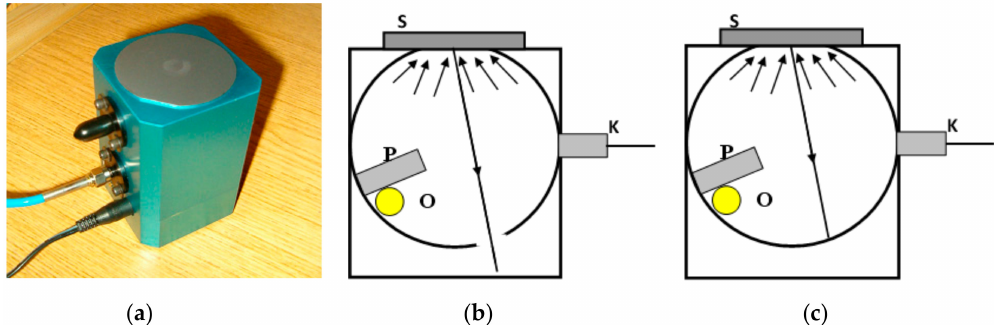
Figure 3. A view of the Ulbricht sphere applied for measurements of reflectance ( a ); and a scheme of the sphere design (O—source of white light, S—tested sample, P—aperture, K—fiber optics cable): ( b ) the aperture setting to measure the specular and di ff use reflections; ( c ) the aperture setting to measure the di ff use reflections only.